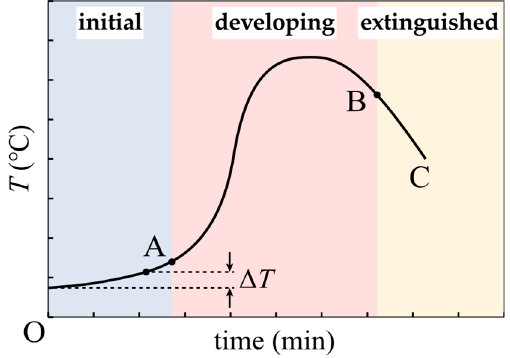
Figure 1. The curve of indoor fire temperature–time.